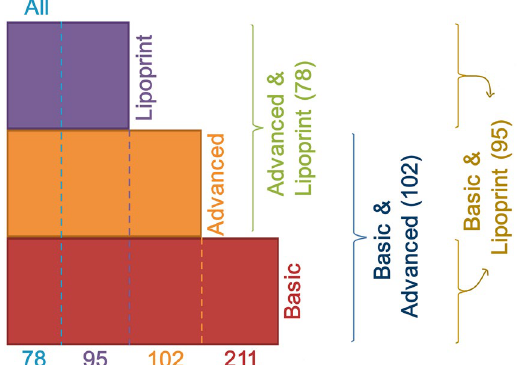
Figure 1. Data subsets used for model training. Figure shows how PFHS-ped was divided into smaller subsets, identified by a color-coded size (number of individuals) and name, according to the available biochemical parameters for each